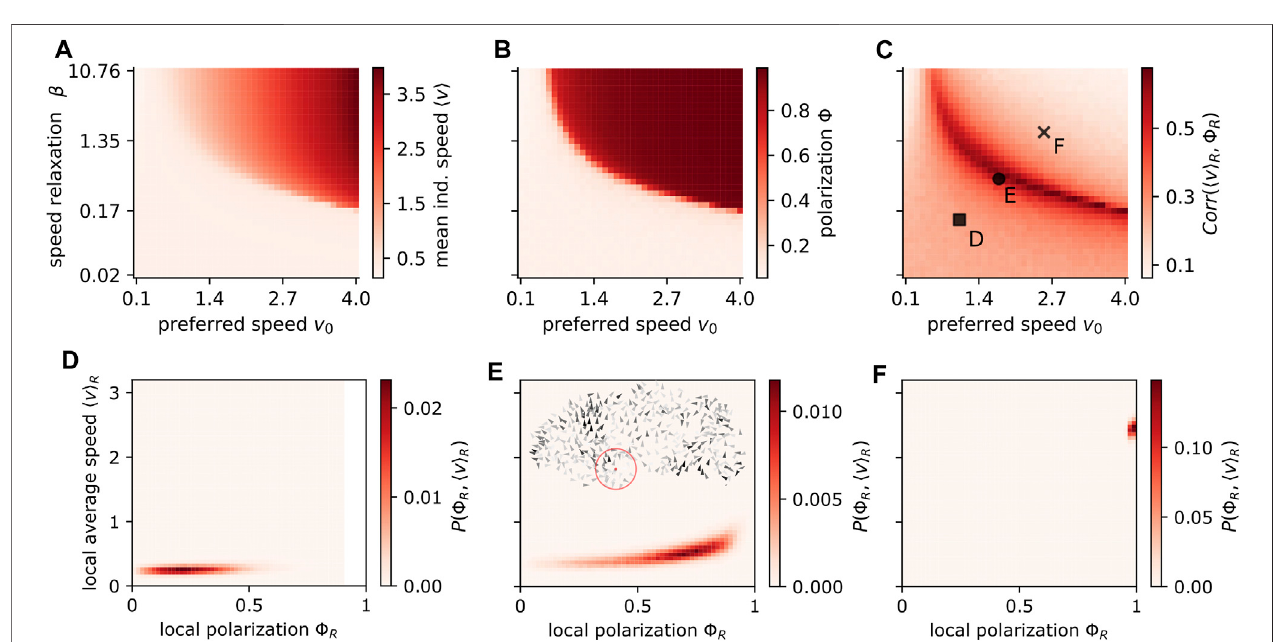
FIGURE 3 | In fl uence of preferred speed and speed variability on polarization and speed-polarization coupling. The preferred speed v 0 and the speed variability (modulated by the speed relaxation β ) both affect the individual speed (A) and modulation of either of these parameters may induce orientational order marked by ahigh polarization Φ (B) .Thetransitiontoordercanbeunderstoodbyalocalcouplingbetweenthelocalaveragespeed 〈 v 〉 R andthelocalpolarization Φ R ,whichwequanti fi ed via their correlation Corr ( 〈 v 〉 R , Φ R ) (C) . The local averages consider all individuals within a circle of radius R (cid:1) 3 around a focal one (red circle in inset (E) . Note that 〈 v 〉 R is not the local group velocity (where a positive correlation with order is trivial) but the local average of the individual speed magnitudes. The speci betweenlocalspeed andorderforthreespeci fi cparameter choices (marked bysquare,circleand crossin (C) isshown forthedisordered state (D) ,thephasetransition region (E) andtheorderedstate (F) .Asnapshotofasimulation(inset (E) )whereagentswithhigherspeedaredarkercolored,withparameterscorrespondingtotheblack circle in (C) . The parameters of the simulations are listed in Table 2 ; Supplementary Table S5 .